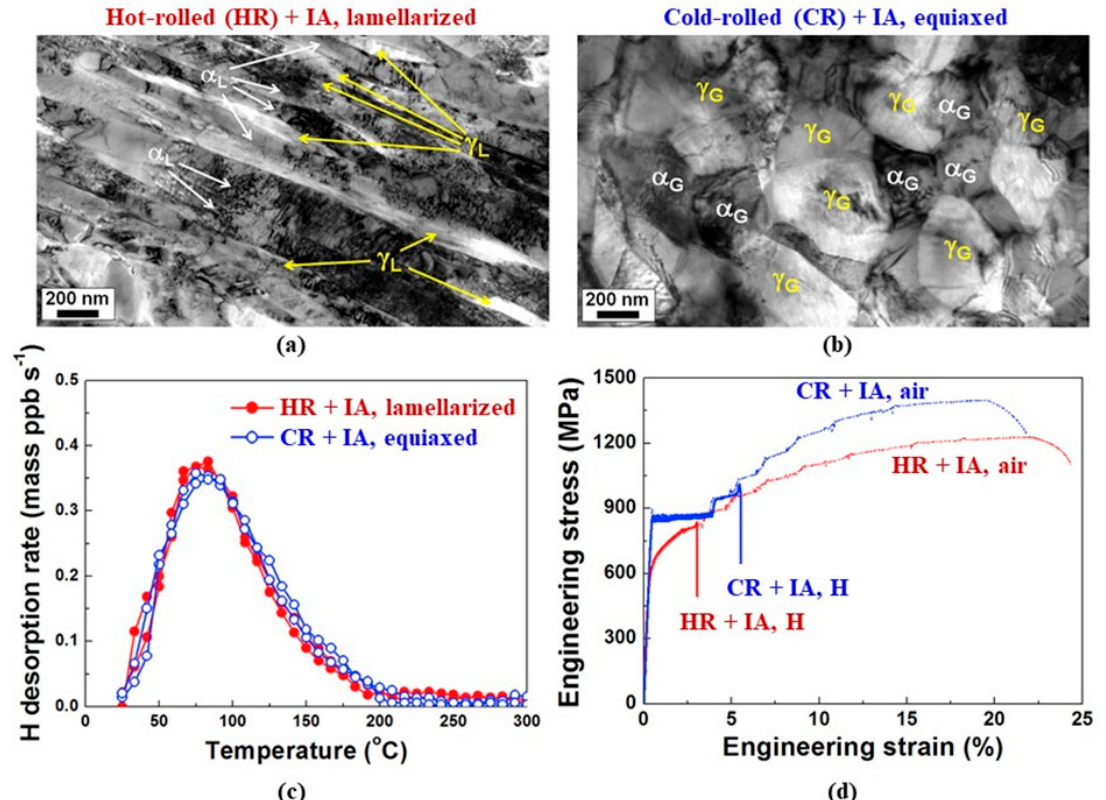
Figure 3. TEM micrographs of ( a ) lamellarized and ( b ) equiaxed morphologies, produced by IA of hot-rolled and cold-rolled medium-Mn steels (Fe–7Mn–0.1C–0.5Si, in wt pct), respectively; α L and γ L are lath–shaped (lamellarized) ferrite and retained austenite, respectively; α G and γ G are globular-shaped (equiaxed) ferrite and retained austenite, respectively. ( c ) Thermal desorption analysis (TDA) curves of the specimens pre-charged with H under the same charging conditions. ( d ) Engineering stress–strain curves obtained by SSRT. Reproduced from Reference [36], with permission from Elsevier.